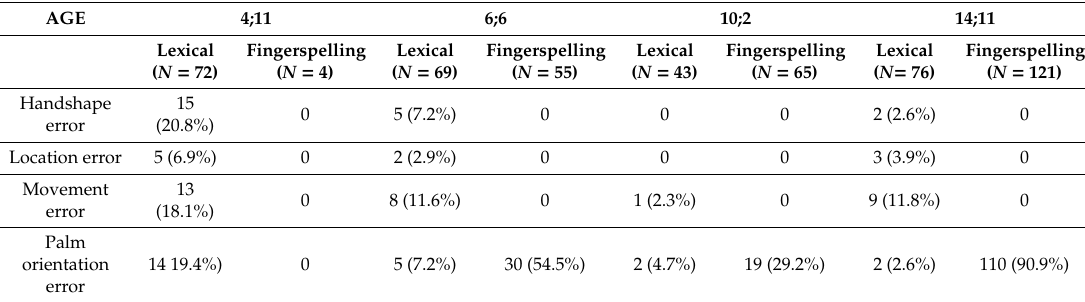
Table 3. Errors on lexical signs and fingerspelled letters at each age, classified by parameter.